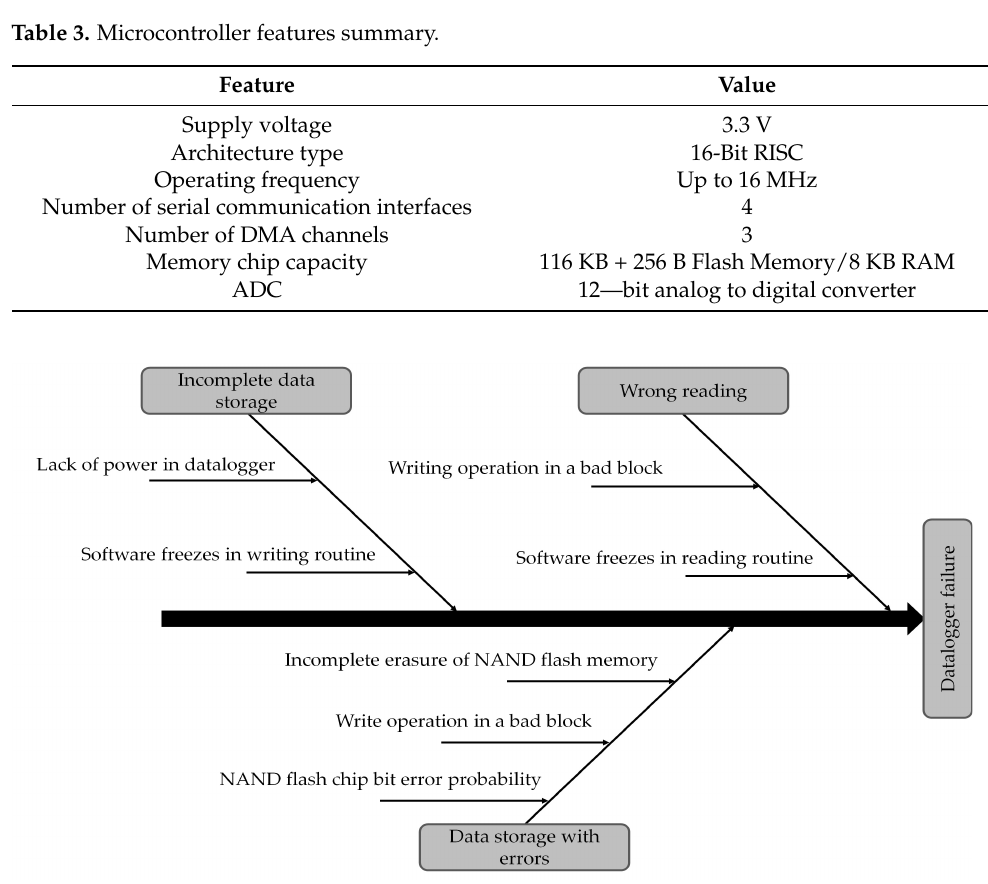
Figure 2. Ishikawa diagram for the evaluation of the cause-and-effect relationships in the datalogger storage and reading